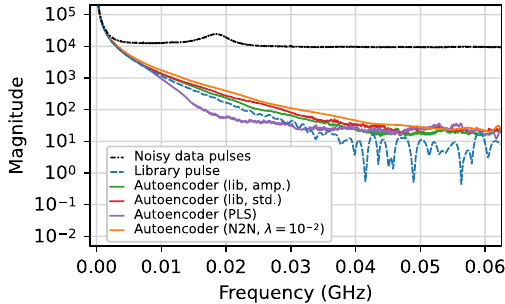
Fig. 13 Comparison of the frequency spectra for simulated library pulses, noisy pulses, and pulses denoised with four different autoen- coder